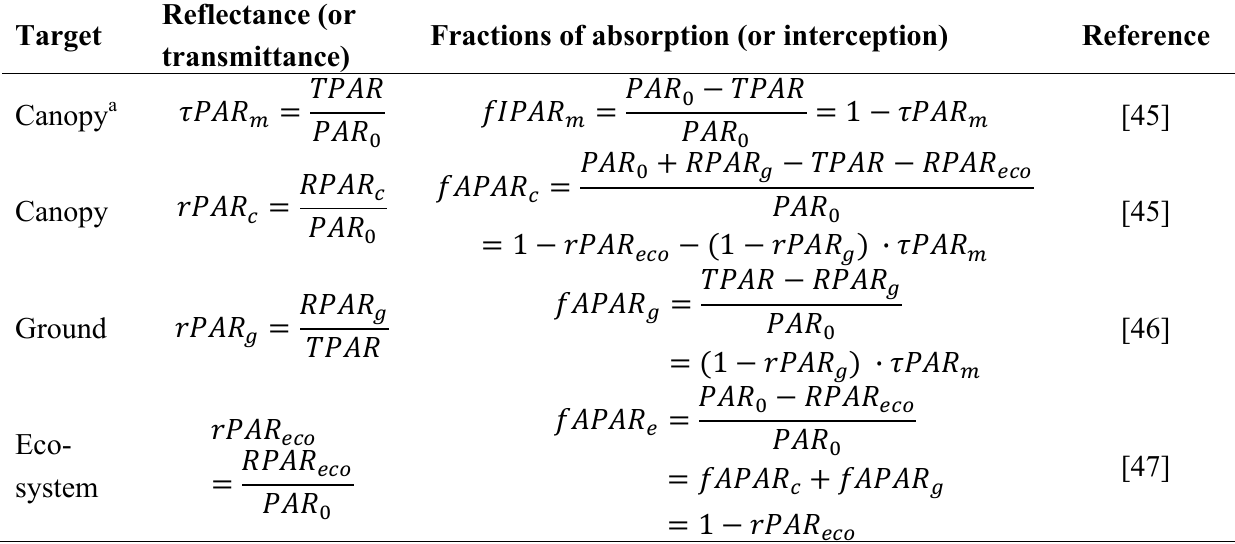
is the (cid:3030) , after (cid:3032)(cid:3030)(cid:3042)